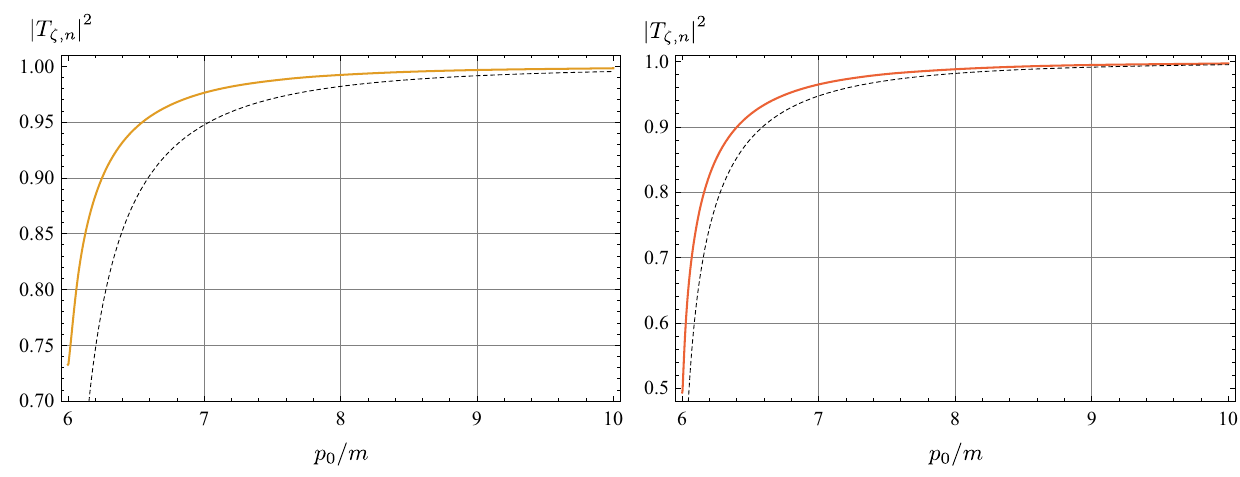
Fig. 6 Probabilities of Fermions transmission through symmetrical inverse potential steps in (cid:19) 1 . Exact results, given by Eqs. (99) and (38), are represented by solid lines while asymptotic ones, given by Eq. (100), are represented by dashed curves. In the left panel, E = 250 E c